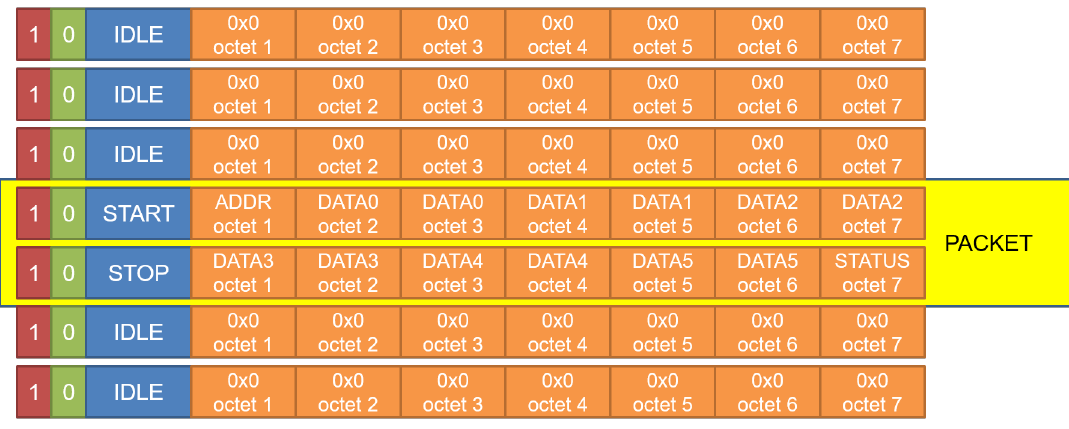
Figure 5. Example of packet